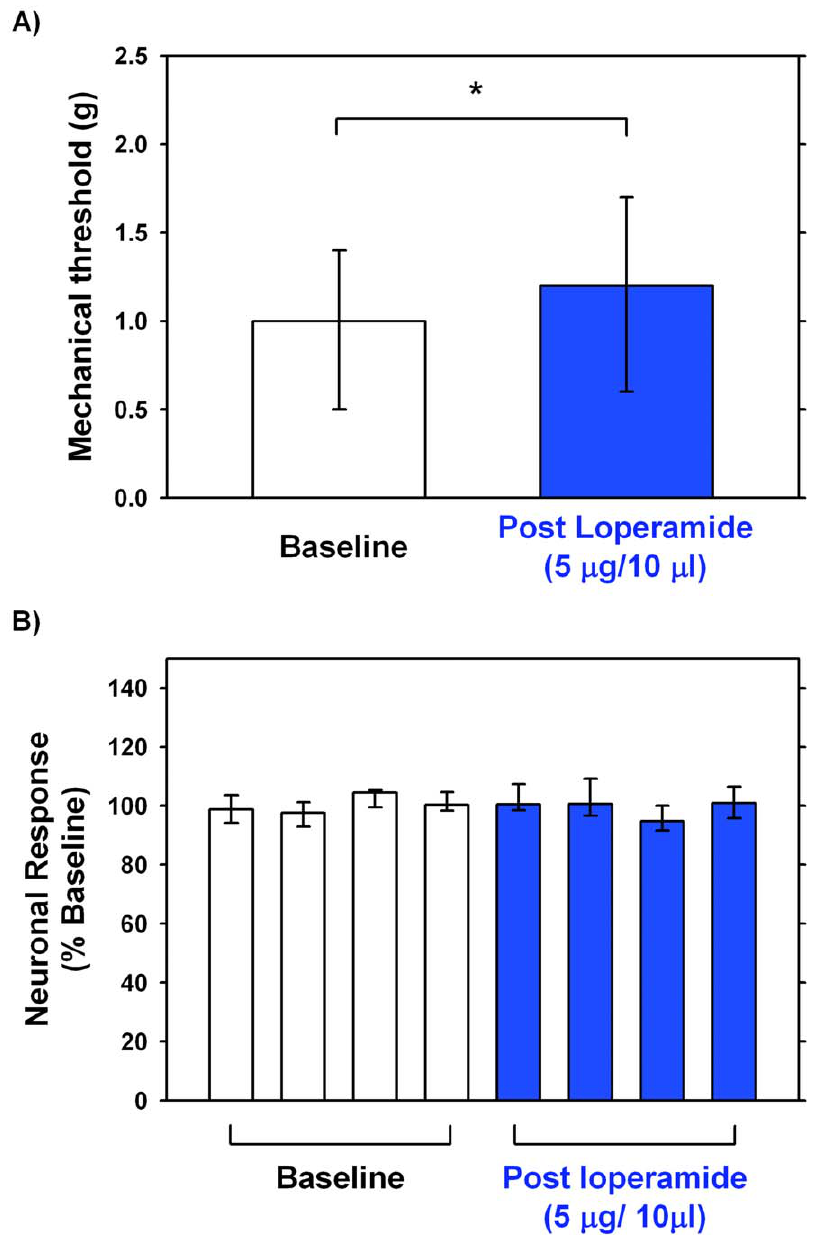
Figure 4. Effects of loperamide on myelinated low-threshold mechanoreceptors. An experimental protocol identical to that used in C- fibers was employed to investigate the effects of loperamide (5 m g/10 m l) on the mechanosensitivity of slowly adapting A b - fibers (CV: 26.6 m/s. n=10) innervating the glabrous skin of the hind paw. A) Loperamide increased mechanical von Frey thresholds significantly (*p , 0.05, Wilcoxon matched pairs), but only slightly (median, before vs after: 1.0 g vs 1.2 g shown). Importantly, all afferents remained sensitive to mechanical stimulation. Medians, 25th percentile and 75th percentiles are shown. B). Loperamide (5 m g/10 m l) did not significantly change the responses to suprathreshold stimulation (Friedman ANOVA, p: n.s., n=10). To compare responses to suprathreshold stimulation (8 g) across fibers, each response in a given fiber was normalized by dividing it by each fiber’s grand average, i.e. the average of the responses in the 4 trials prior to injection of loperamide. These normalized data were then used for statistical analysis. Medians, 25th percentile and 75th percentiles are shown. doi:10.1371/journal.pone.0042105.g004 regression lines of the dose- response curves as shown in Fig. 7. For Fig. 7B), the C-CAP under loperamide was significantly smaller the C-CAP, the ED50 was 4.0 m g/10 m l, whereas the ED50 for A- than the A-CAP (p , 0.05, Wilcoxon matched pairs). These finding suggests that A-fibers are less susceptible to the effects of CAP was about 8 m g/10 m l. As illustrated in Fig. 7A, the confidence intervals of the 2 linear regression curves slightly loperamide than C-fibers. overlapped, suggesting that the ED 50 for the A- and C-CAP do not significantly differ. However, when we compared the average effect of loperamide across the different concentrations used (see